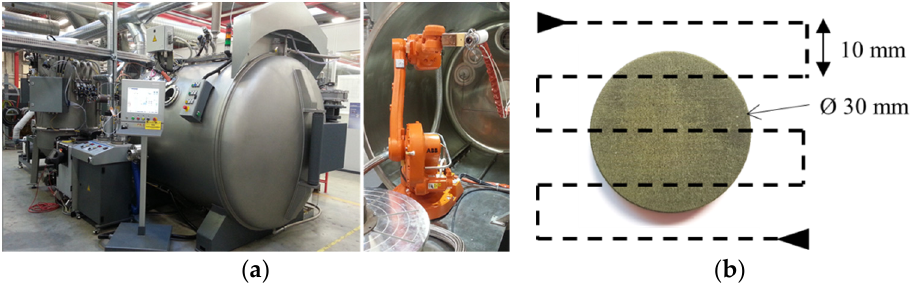
Figure 1. ( a ) Vacuum plasma spray system; ( b ) C/C composite substrate and robot path.